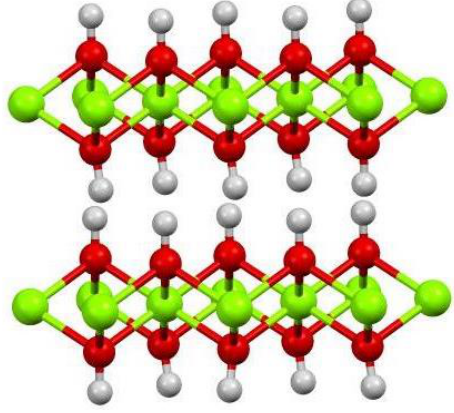
Figure 7. Three-dimensional (3D) structure of flake MH.